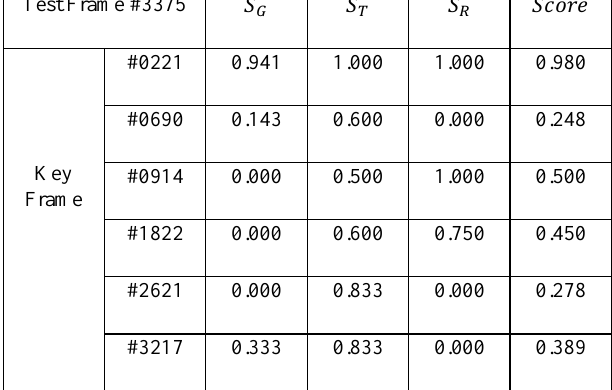
Table 1. Quantitative assessment of matching a test frame (#3375) to the selected keyframes.